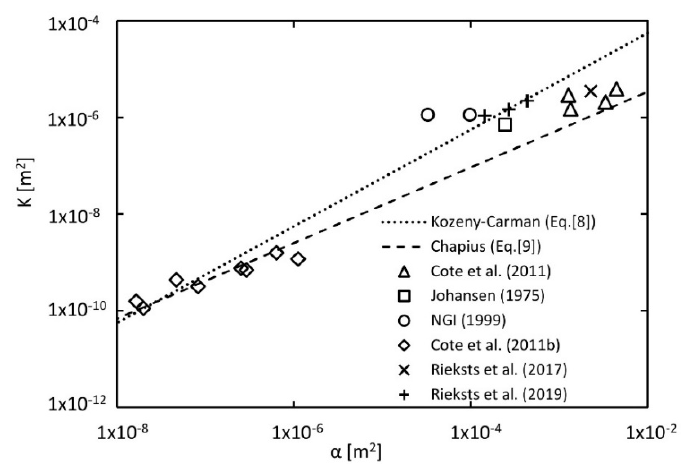
Figure 20. Measured and predicted K-α relationships